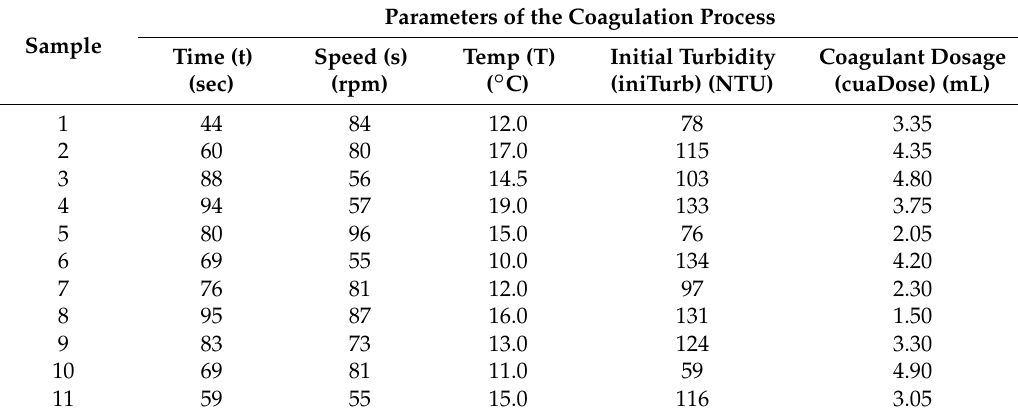
Table 12. Test matrix for clarification process in waste water treatment.